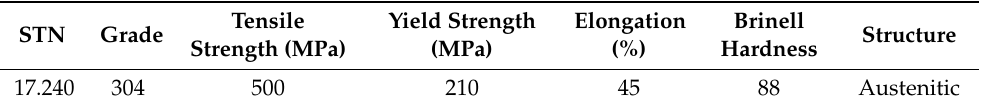
Table 2. Mechanical properties of AISI 304 [17].